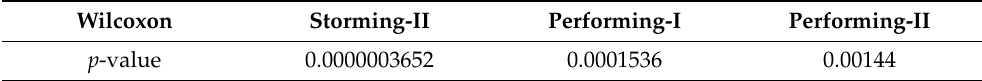
Table 8. Wilcoxon test between experimental and control groups.